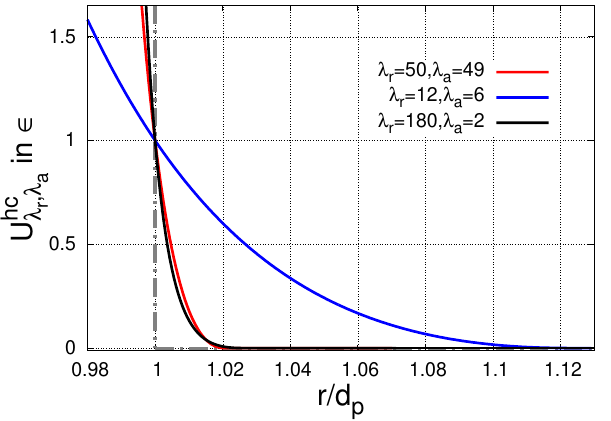
Figure A1. Plotting the generalized cut-and-shifted potentials from Equation (A15) for selected λ r and λ a . As a guide to the eye, we additionally sketch the ideal hard core potential as a grey dashed-dotted line. The classical Lennard-Jones potential (blue) can only very poorly resemble the ideal form—especially, since neighboring microspheres should only start to ’feel’ each other (beside the hydrodynamic interaction included in f el in Equation (A13)), as they really come to physical ( r ) or U hc ( r ) much more contact at r d p , making alternative forms like U hc 50,49 180,2 ≈